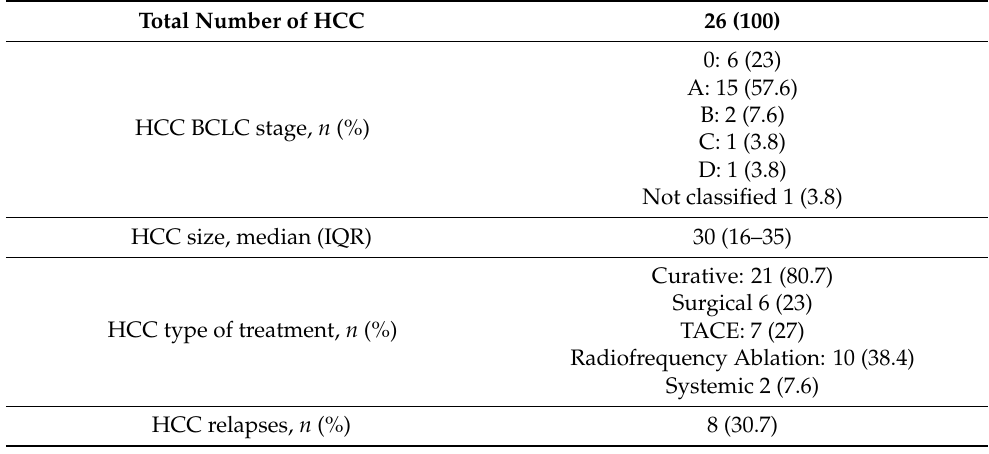
Table 3. Characteristics of hepatocellular carcinoma cases included in the